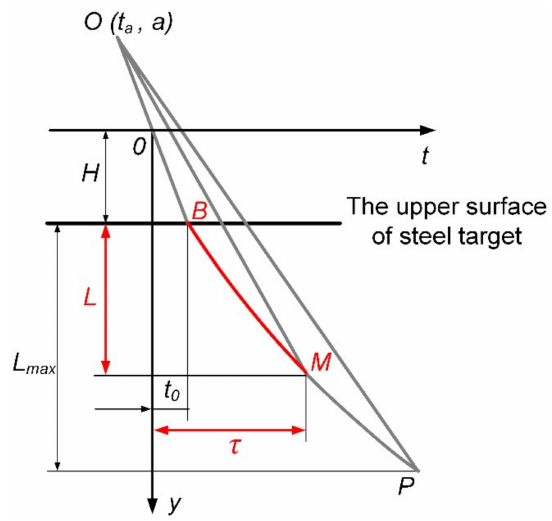
Figure 12. Theoretical model of penetration depth for a high-density reactive jet against a steel